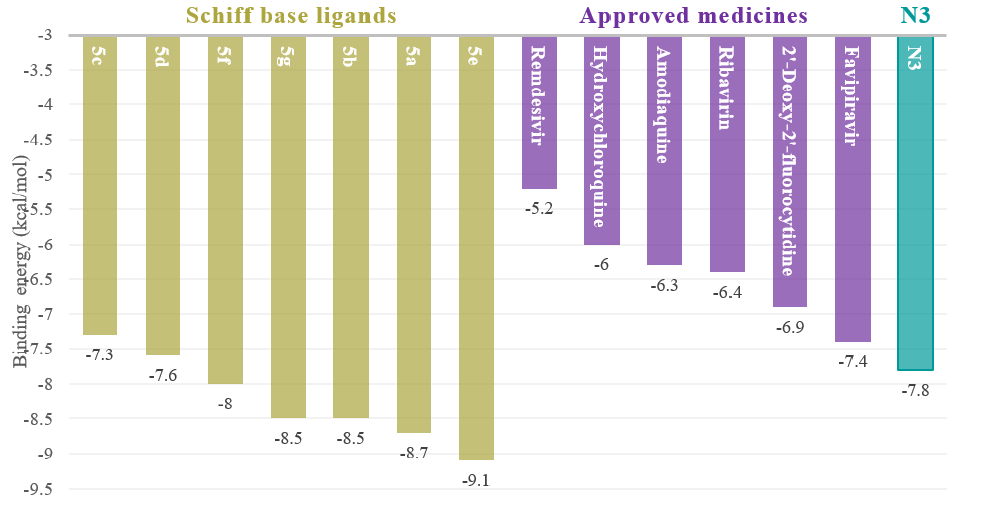
Figure 4. Binding affinities of SBs 5a – g against COVID-19 7BQY protease (left). On the other side, approved medicines and ligand N3 for comparison.